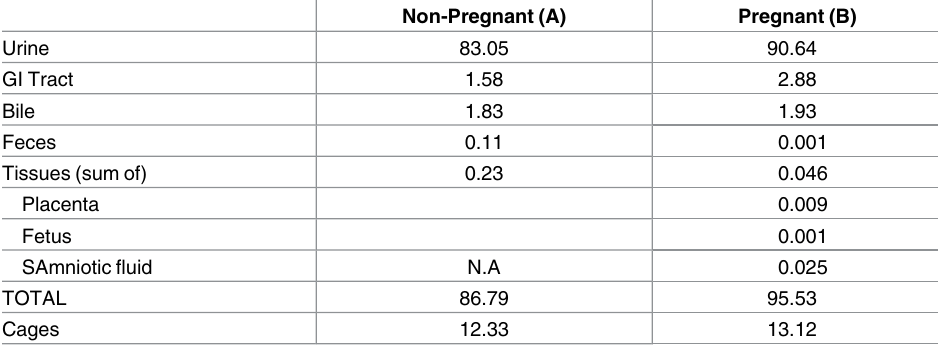
Table 4. 3 H-BPA 24 hr metabolic balance in a non-pregnant (A) and a pregnant (B) monkey orally dosed with 4.5 and 7.8 μ g/kg BW 3 H-BPA, respectively. Results are expressedin percentageof the administered